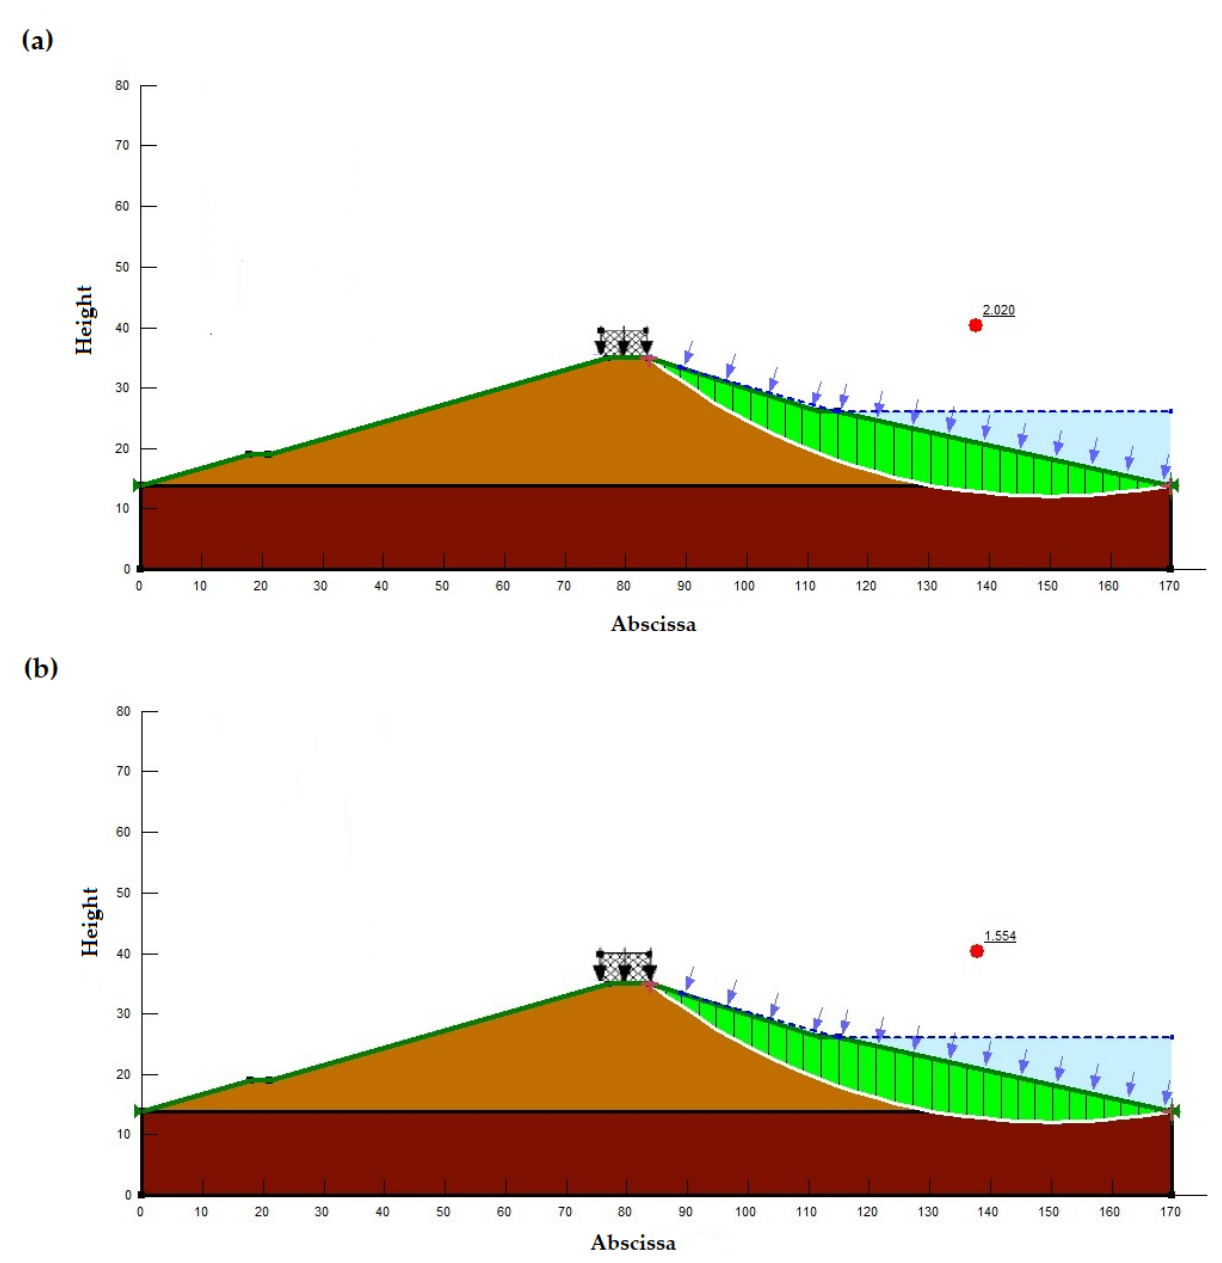
Figure 14. The safety factor of the downstream slope. ( a ) Slope stabilization with applied loads. ( b ) Slope stabilization with seismic analysis.